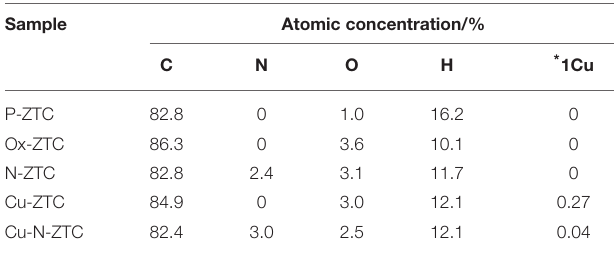
TABLE 1 | Elemental compositions of zeolite-templated carbon (ZTC) samples determined from temperature-programmed desorption (TPD) and atomic absorption analysis